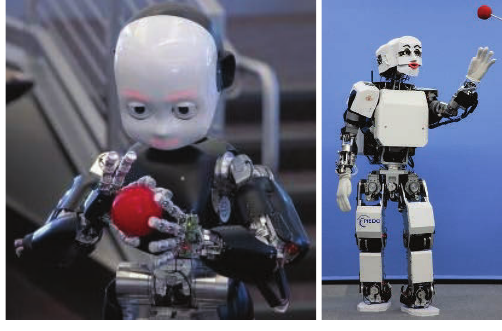
Figure 2. SnapshotsoftheiCubSimulatorgrabbingthetwodi(cid:636)erenttoolsused in the experiments: on the left, the 28 cm stick tool, on the right, the 48x30 cm L-shaped tool.